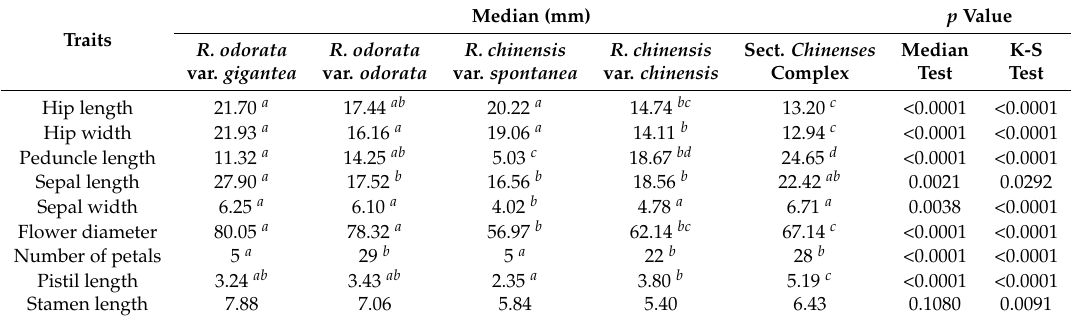
Table 2. A single-factor analysis of variance (ANOVA) of quantitative traits of R. sect. Chinenses .